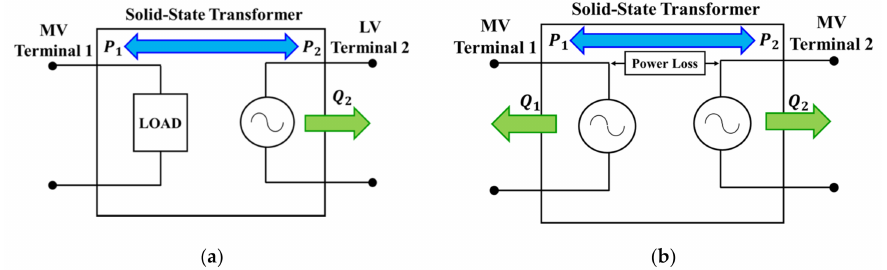
Figure 3. SST model for OpenDSS: ( a ) conventional MV-to-LV SST model [10] and ( b ) proposed MV-to-MV SST model.